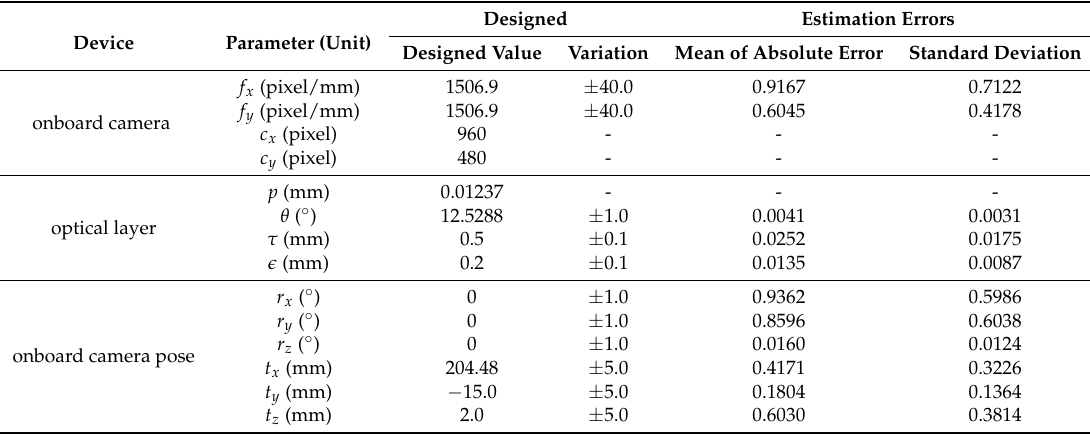
Table 2. Designed parameters and experimental results in the simulation